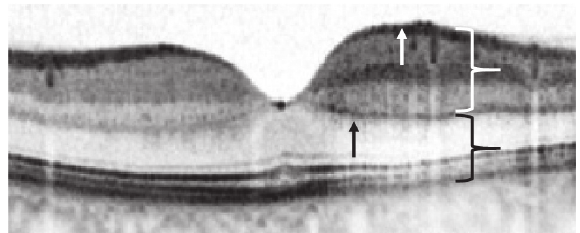
Figure 5: Signs of acute retinal ischemia in optical coherence tomography. This figure displays an optical coherence tomography (OCT) scan of a branch retinal artery occlusion with a time of symptom onset < 2 hours. On the left side of the fovea, the retinal perfusion is intact, and the structure of the retinal layers is physiological. On the right side, where the branch retinal artery occlusion occurred, signs of ischemia can be seen in the scan. The white curly brace shows the hyperreflectivity in the inner layers of the retina. Consequently, the outer retinal layers and the retinal pigment epithelium show a hyporeflectivity—pointed out by the black curly brace. The black arrow points to the prominent middle-limiting membrane sign (pMLM). The white arrow symbolizes the thickening of the retina in comparison to the nonaffected part of the retina on the left